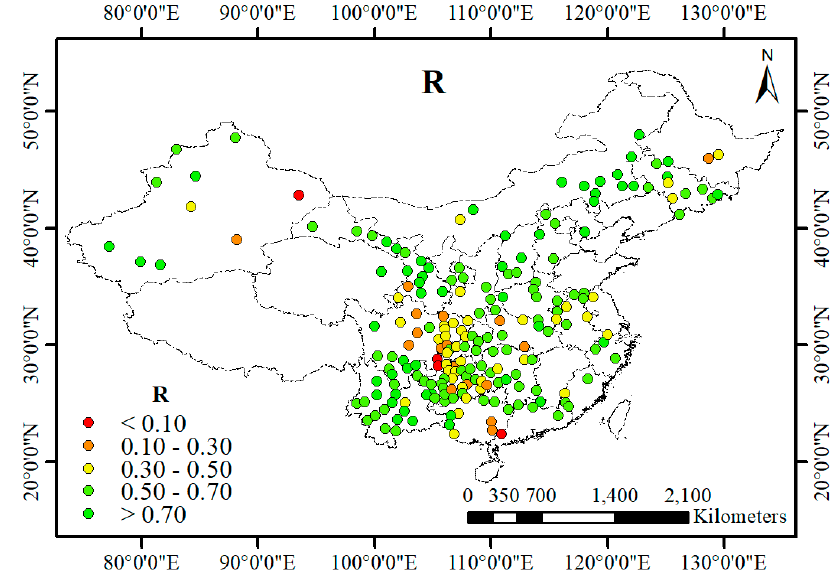
Figure 8. Pearson correlation coefficient (R) between the weekly SWDI-SMAP and AWD at 204 monitoring stations with both SM and climate data. 30 pairs of 7-day averaged data were used from 1 April 2016 to 30 September 2016.